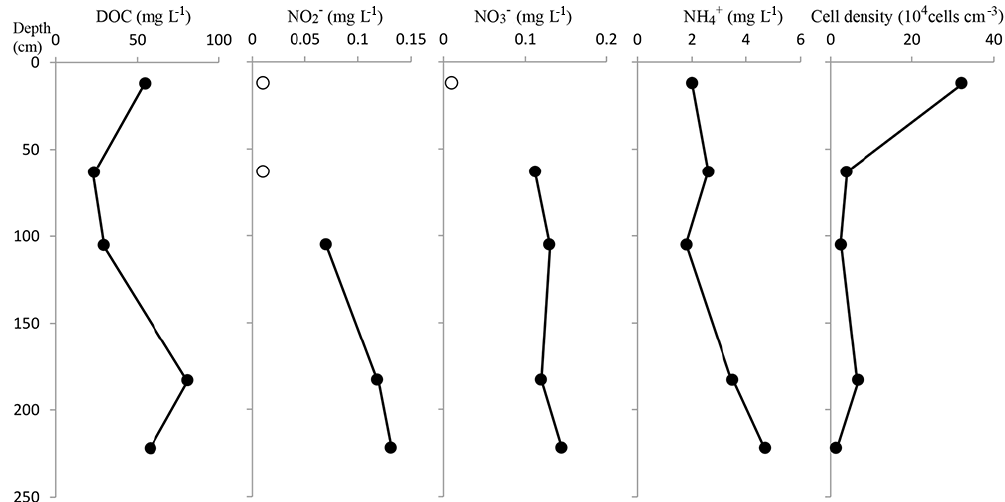
Figure 3. Nutrient measurements and cell counts in the different sediment layers. The pore water samples were analyzed for five layers of a sediment core obtained from the Atlantis II Deep (21 ◦ 20.76 (cid:48) N, 38 ◦ 04.68 (cid:48) E) in 2008. DOC: dissolved organic carbon.